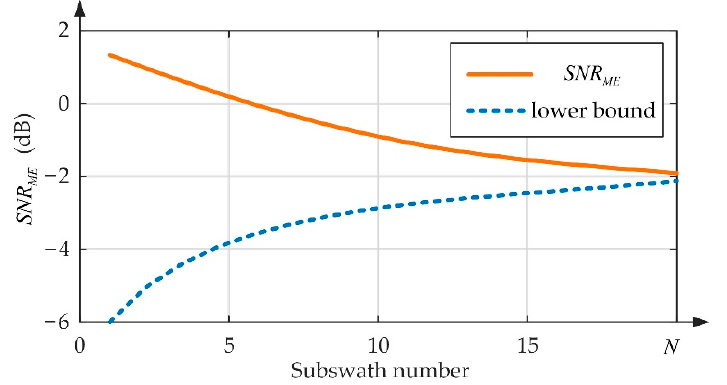
Figure 15. Illustration of SNR ME curves for different subswath numbers, where N is the number of subswaths.